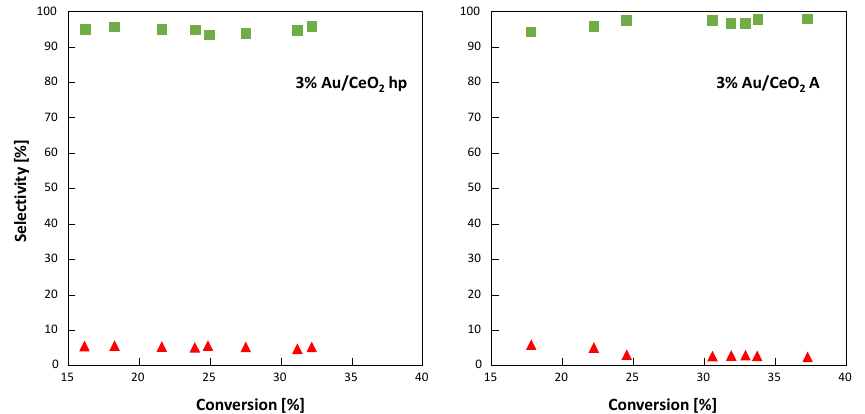
values were observed for 3%Au/CeO 2 hp), indicating that no other species were formed during the 4-MBA partial oxidation. Figure 9. Natural solar light assisted partial photocatalytic oxidation of 4-MBA in the presence of the 3% Au-loaded CeO 2 samples. Selectivity towards 4-methoxybenzaldehyde ( ■ ) and 4-methoxybenzoic acid ( ▲ ) versus 4-methoxybenzyl alcohol conversion.